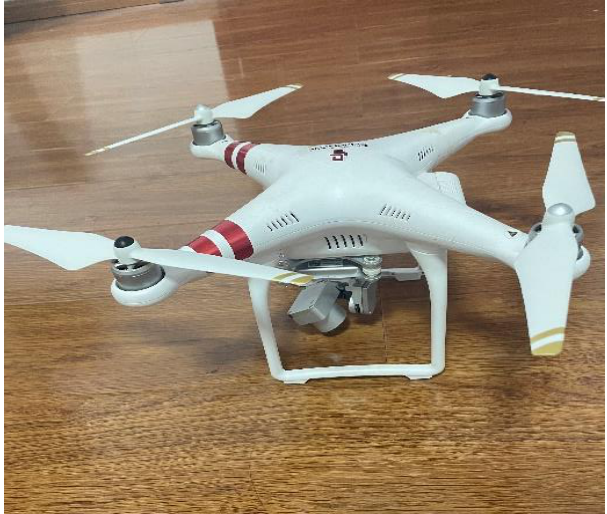
Figure 9. The optical image of the UAV.